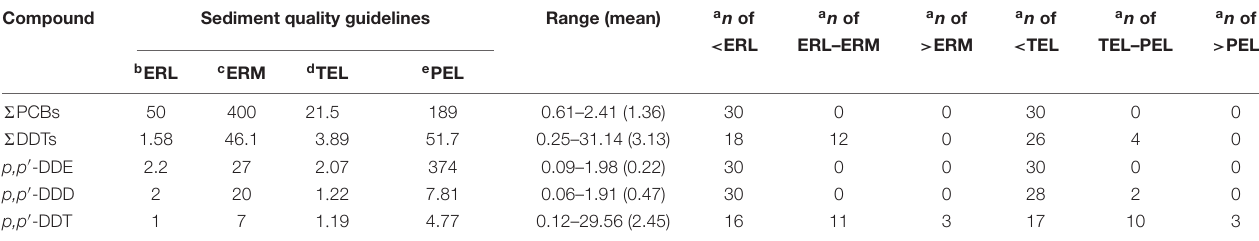
TABLE 2 | Concentrations of PCB and OCP in surface sediments from Qingduizi Bay (ng g − 1 dw) and toxicity guidelines. Compound Sediment quality